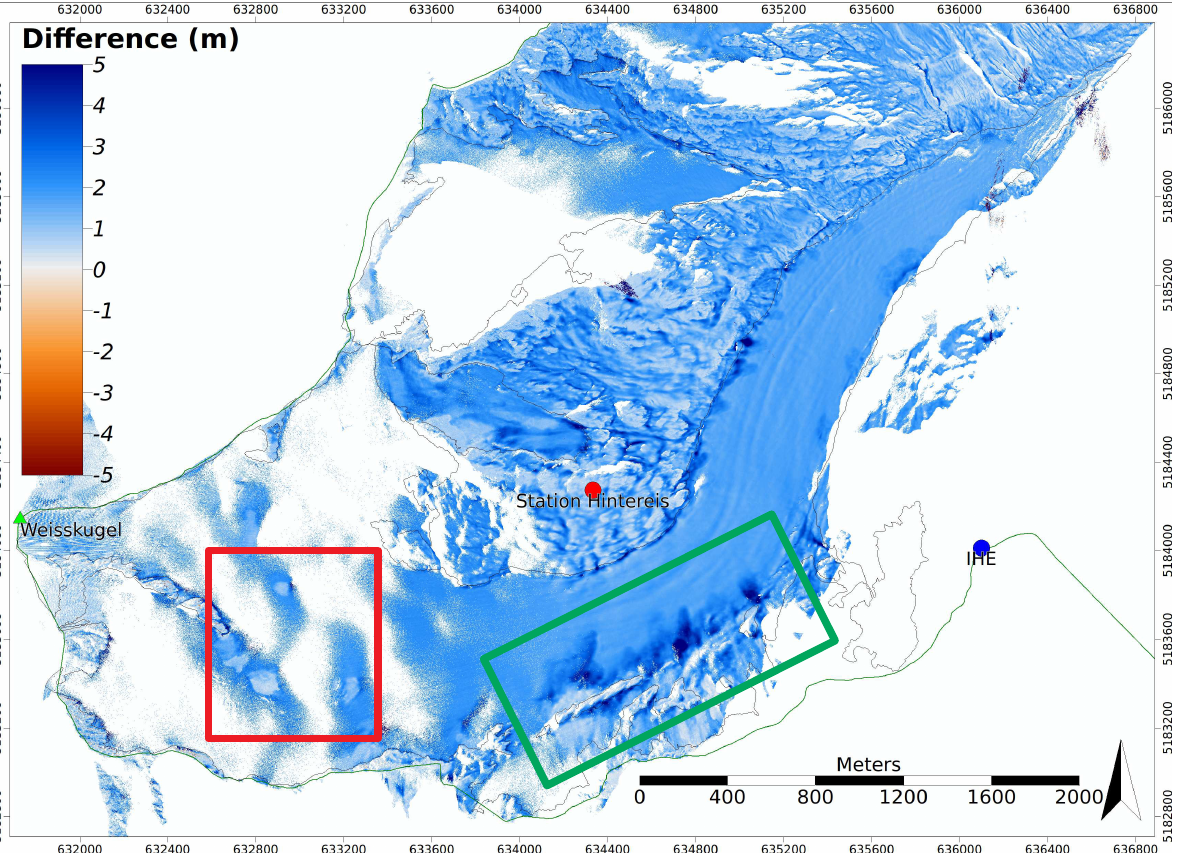
Figure 9. Difference plot between 1 and 10 December 2020. Snow erosion (red) and snow deposition (green) caused by avalanches (cid:1) has been marked with